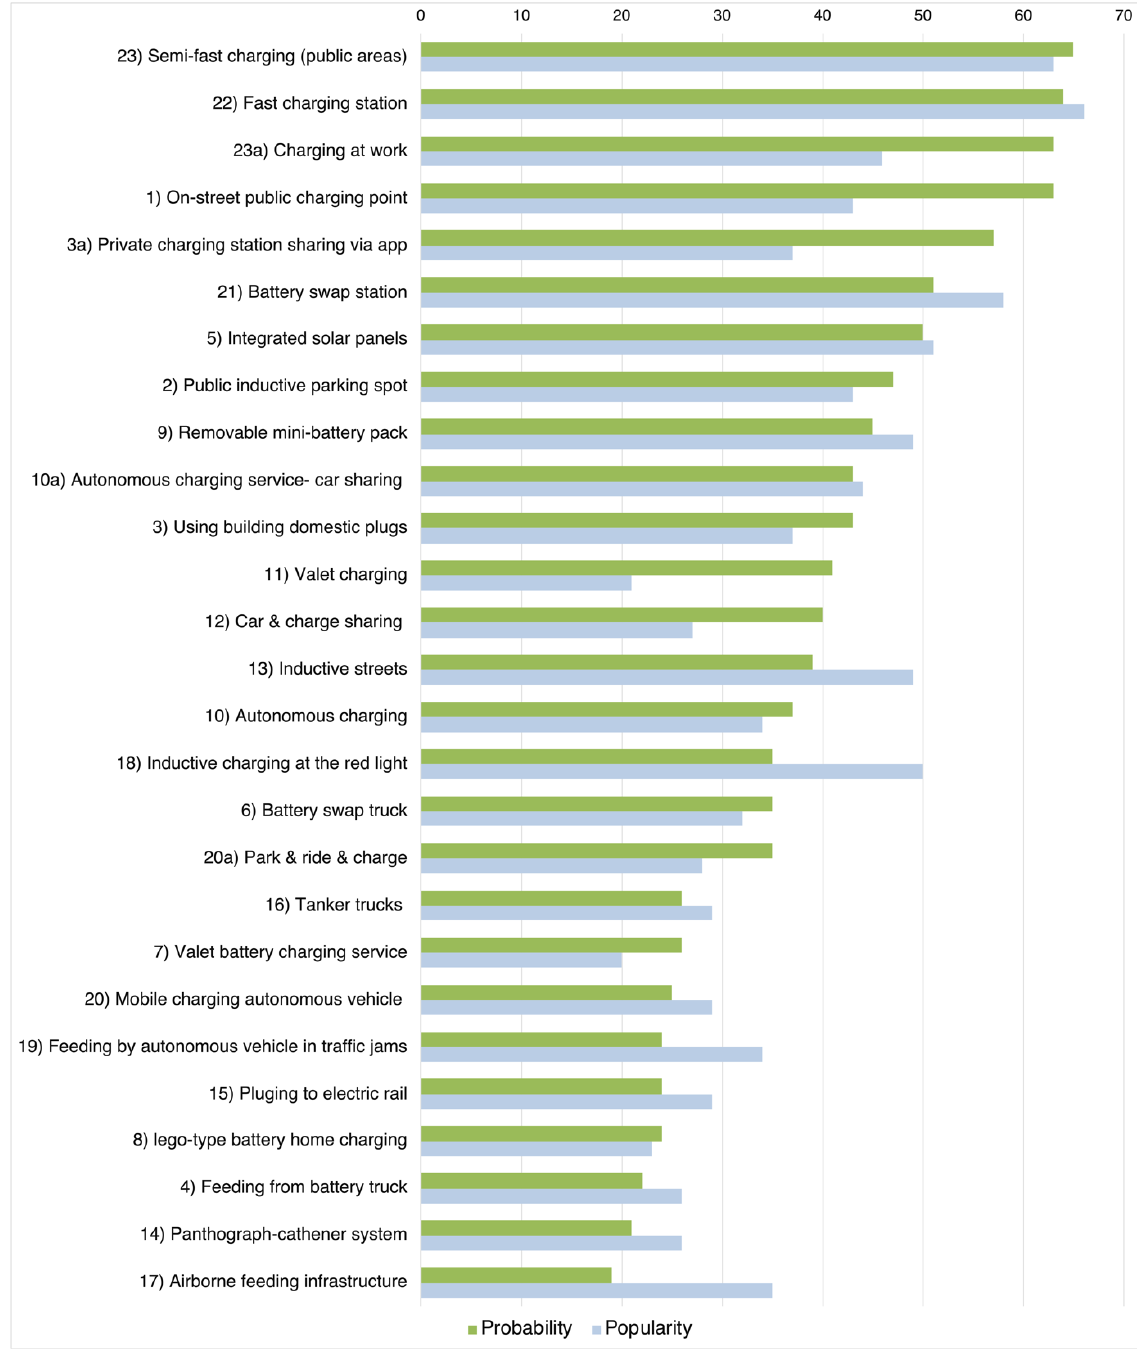
Figure 4. Probability and popularity rating of the expert panel for potential EV charging solutions Each solution was also rated for its expected share of use amongst available solutions in 2035 (see second variable in Figure 4), assuming the solution would be deployed. In other words, the participants had to answer the question regarding the percentage of time each solution would be used to recharge the vehicles. The top five most popular solutions that emerged are 22) Fast charging